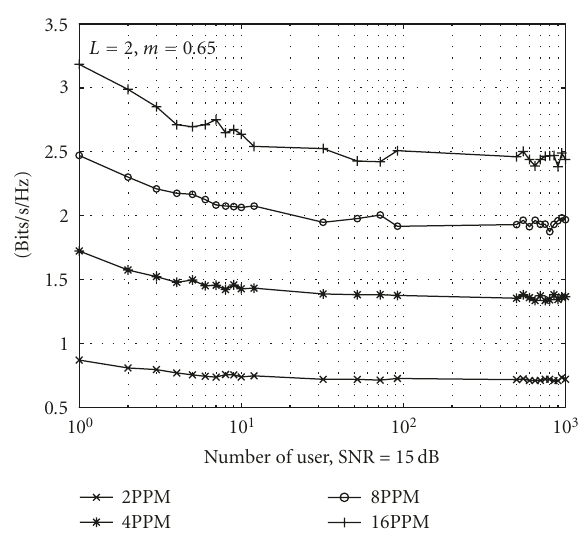
Figure 9: Relationship between channel capacity and number of users for a multiple access UWB system with PPM over a multipath fading channel, L = 2, m = 0 . 65, G = 100, P x = − 11dBm, and SNR = 15